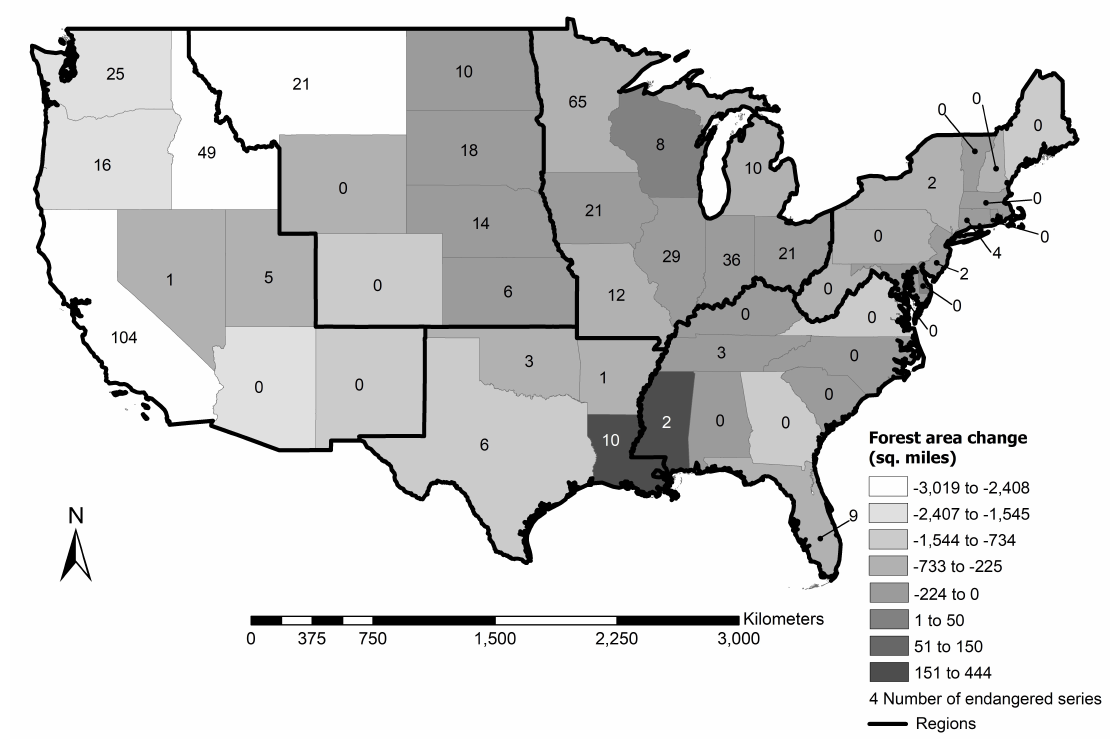
Figure 9. Forest land cover changes over time from 2001 to 2011 in the contiguous United States (U.S.) (adapted from Wentland et al. (2020)